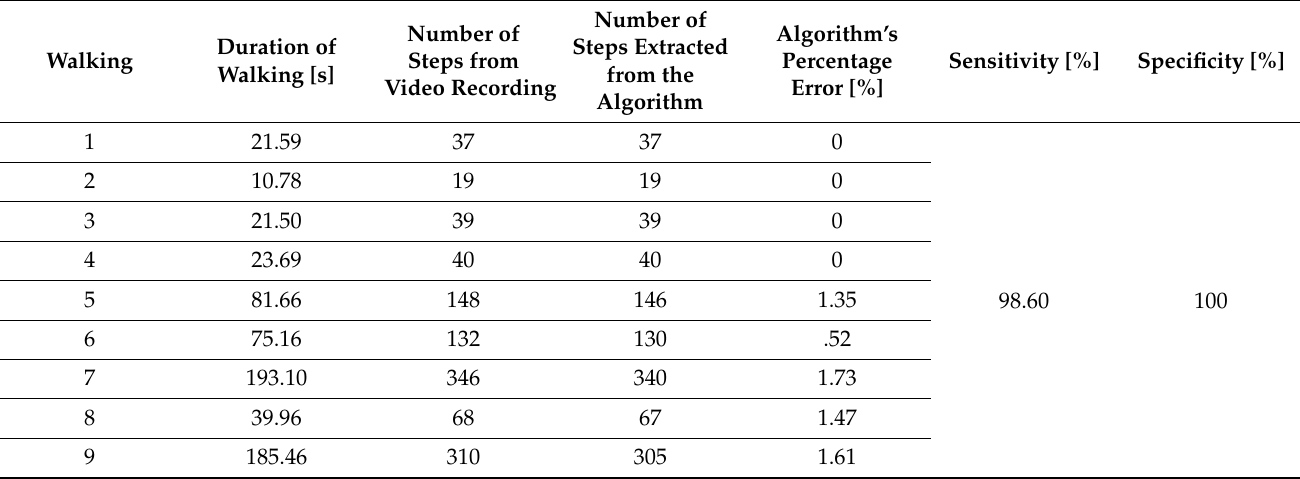
Table 3. Validation values for steps detection in each walking bout performed by a single subjects during the laboratory